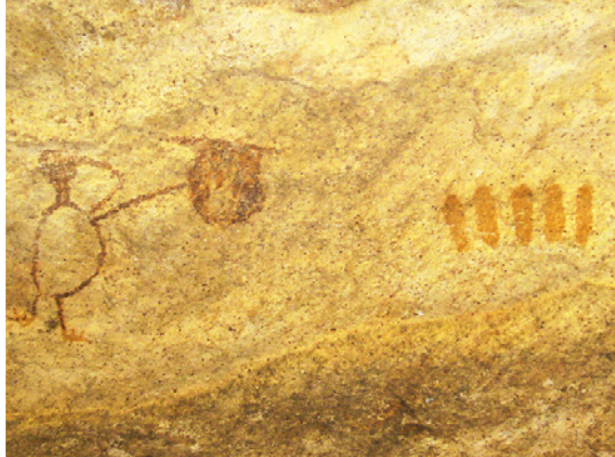
Fig 4 . An ancient cave image from the Serra da Capivara, Northeast Brazil, probably related to hunting stingless bee honey. Courtesy of Acervo da Fundação Museu do Homem